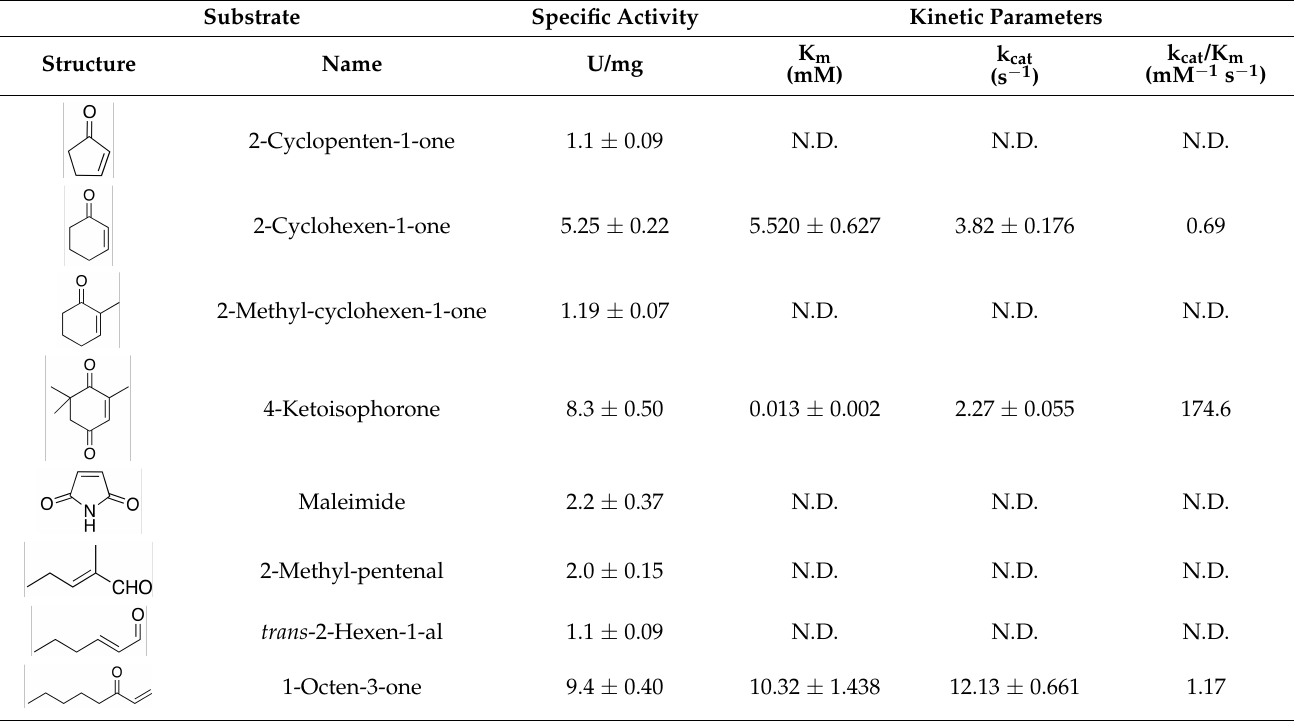
Figure 2. ( a ) Influence of different type and different percentages of organic co-solvents (50 mM Tris-HCl buffer pH 8.0 supplemented with increasing vol% of organic co-solvent) on Ca OYE protein melting point T m ( ◦ C) (as measured by Thermofluor assay). All measurements have been performed in triplicate; ( b ) Ca OYE activity-pH profile: the specific activity (U/mg) was determined by monitoring the reduction of 2-cyclohexen-1-one in the presence of NADPH. A universal buffer of constant ionic strength, 50 mM CAPS, 50 mM Tris-HCl, 50 mM MES and 50 mM AcOH adjusted to different pH values (4.0, 5.0, 6.0, 7.0, 8.0, 9.0, 10.0 and 11.0) at 25 ◦ C by 5 M NaOH or 5 M HCl, was used to determine the activity of the enzyme. Table 1. Substrate scope 1 and steady-state kinetic parameters 2 of Ca